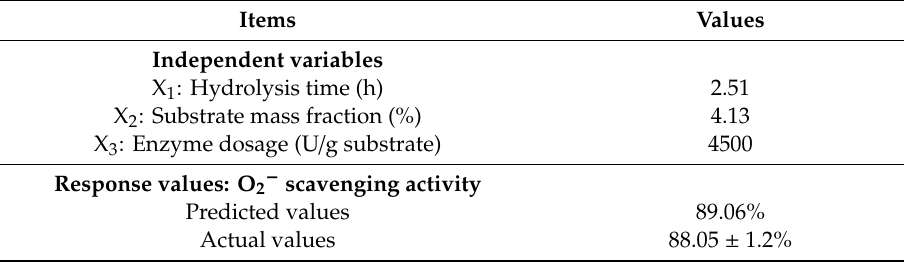
Table 3. Predicted and experimental values of the responses at optimum